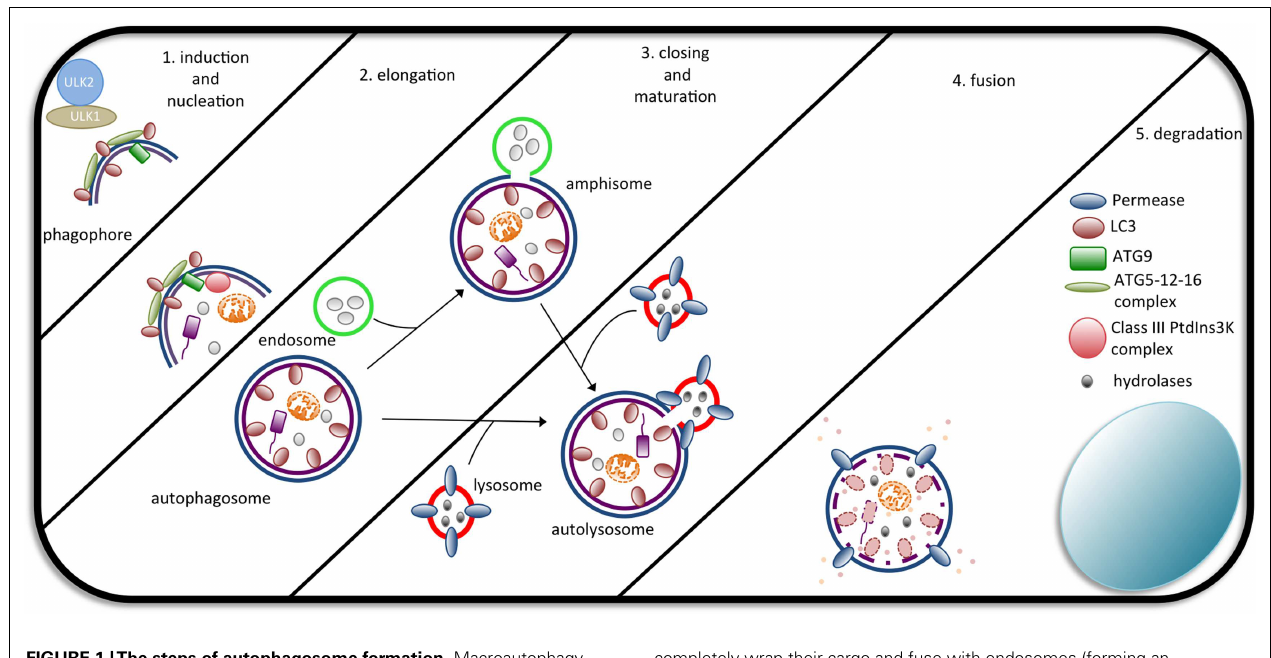
FIGURE 1 |The steps of autophagosome formation . Macroautophagy begins with the formation of a cup-shaped structure called a phagophore as a consequence of the activity of the ULK1/2 complex. In the sequence, the ATG5-ATG12-ATG16L1 complex, Class III PtdIns3K, ATG9, and LC3 assist in the formation of the autophagosome. Autophagosomes